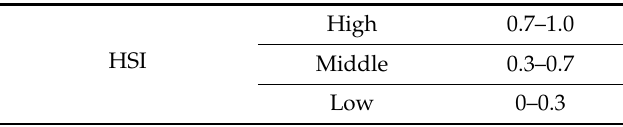
Table 1. High, middle and low classification for